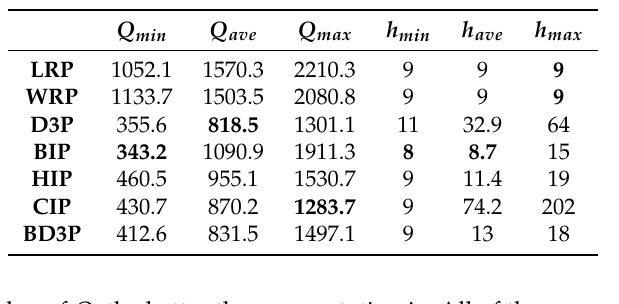
Table 2. Q value and the number of levels of the pyramid for several decimation algorithms (see the text). LRP, linked regular pyramid; BIP, bounded irregular pyramid; HIP, hierarchy of